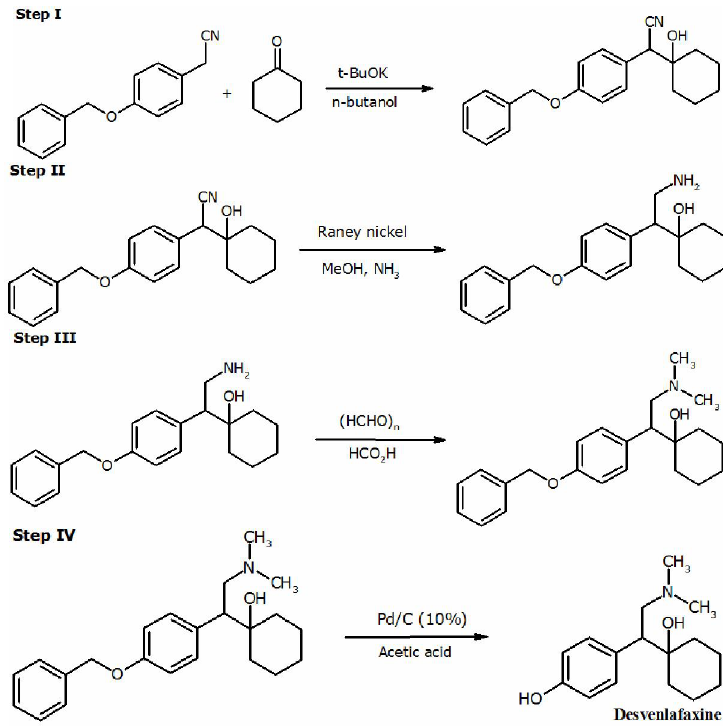
Figure 1. Reaction mechanism for synthesis of new polymorph of